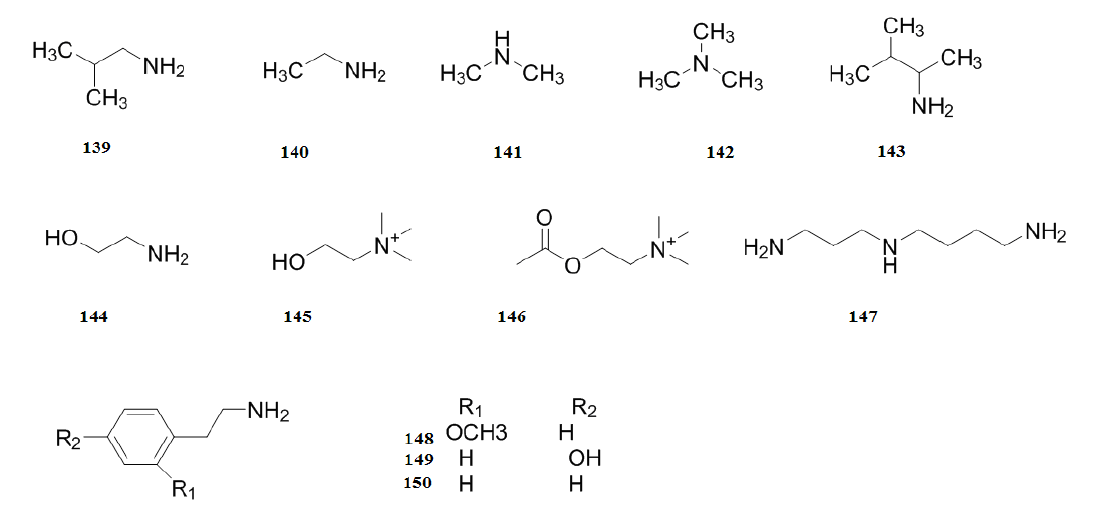
Figure 11. Chemical structures of nitrogen-containing compounds in C. pinnatifida .